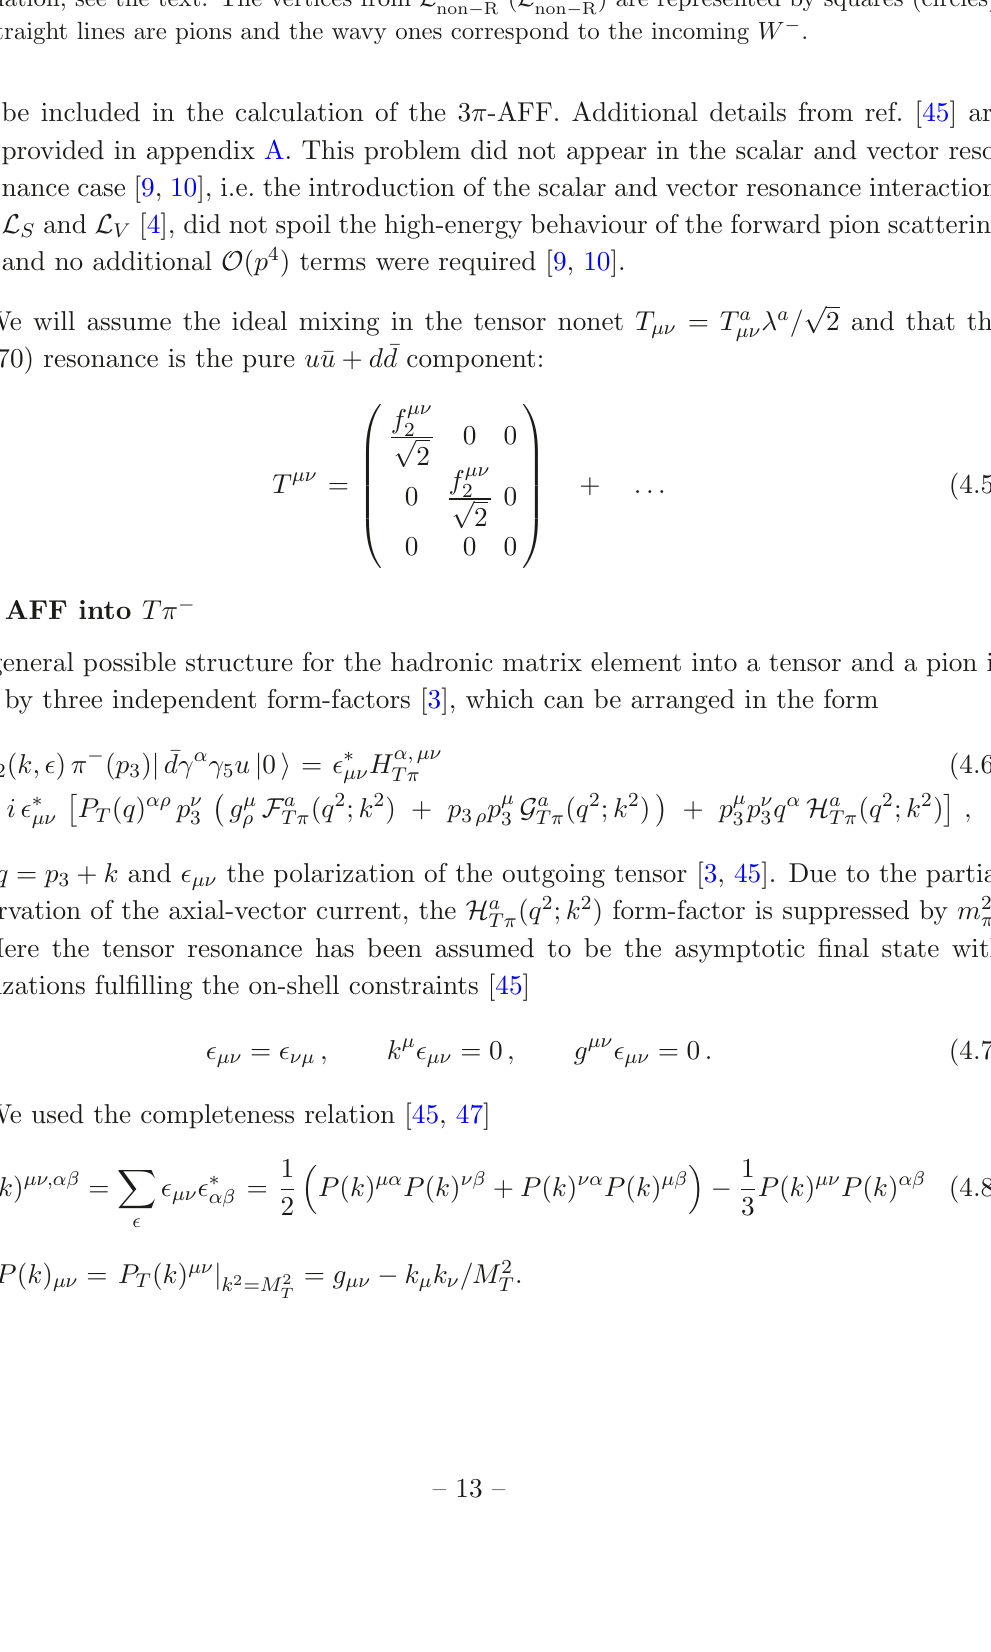
( p 4 ) operators L SD . For a more detailed 1 , 2 , 3 O (4) (2) ( ) are represented by squares (circles). non − R non − R L L